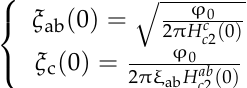
ab c 2  2 . H c c 2  2